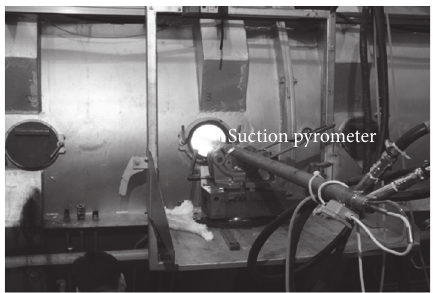
Figure 3: A photo of the positioning of the suction pyrometer.